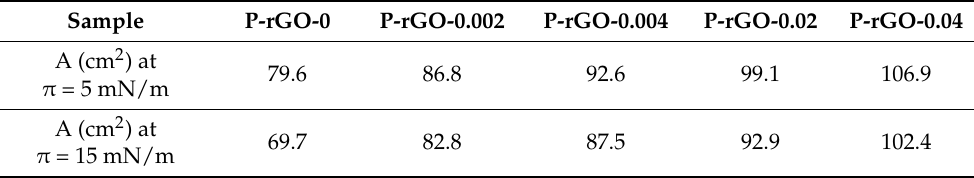
Figure 2. Surface pressure-area ( π -A) isotherms of nanocomposite monolayers. Table 1. Surface area at π = 5 and 15 mN/m as a function of rGO